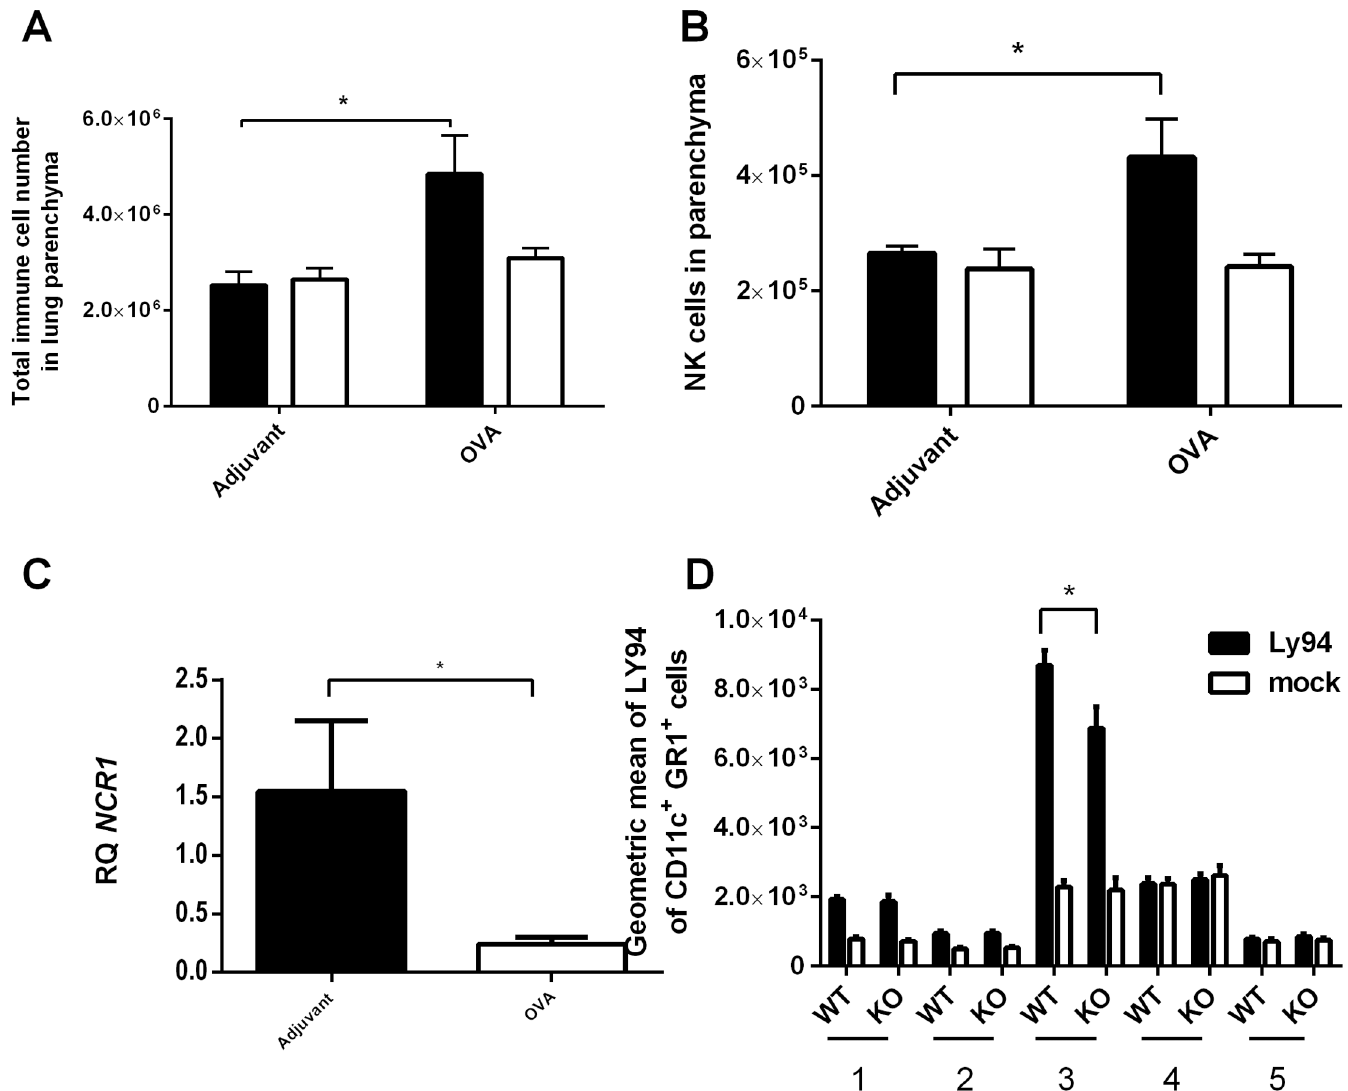
Fig 7. A decrease in NCR1 mRNA expression and increase of NCR1 ligand expression in the BAL of OVA immunized mice. NCR +/+ and NCR gfp/gfp mice were immunized with either adjuvant alone or with OVA/alum as described in the Material and Methods section. The mice were euthanized and the lung tissue was dissociated into single cells. (A) Total number of live immune cell. (B) NK cell number as determined by anti NK1.1 antibody. (C) qRT PCR performed with NCR1 appropriate primers (S1 Table). (D) Five populations of cells carrying or lacking CD11c or GR1 were determined and stained with LY94-Ig fusion protein. * p >